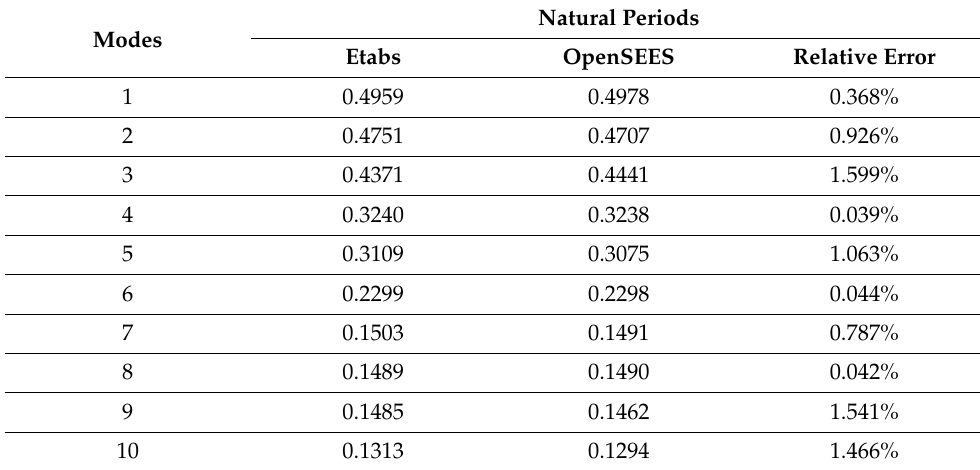
Table 4. Natural periods of the structure.